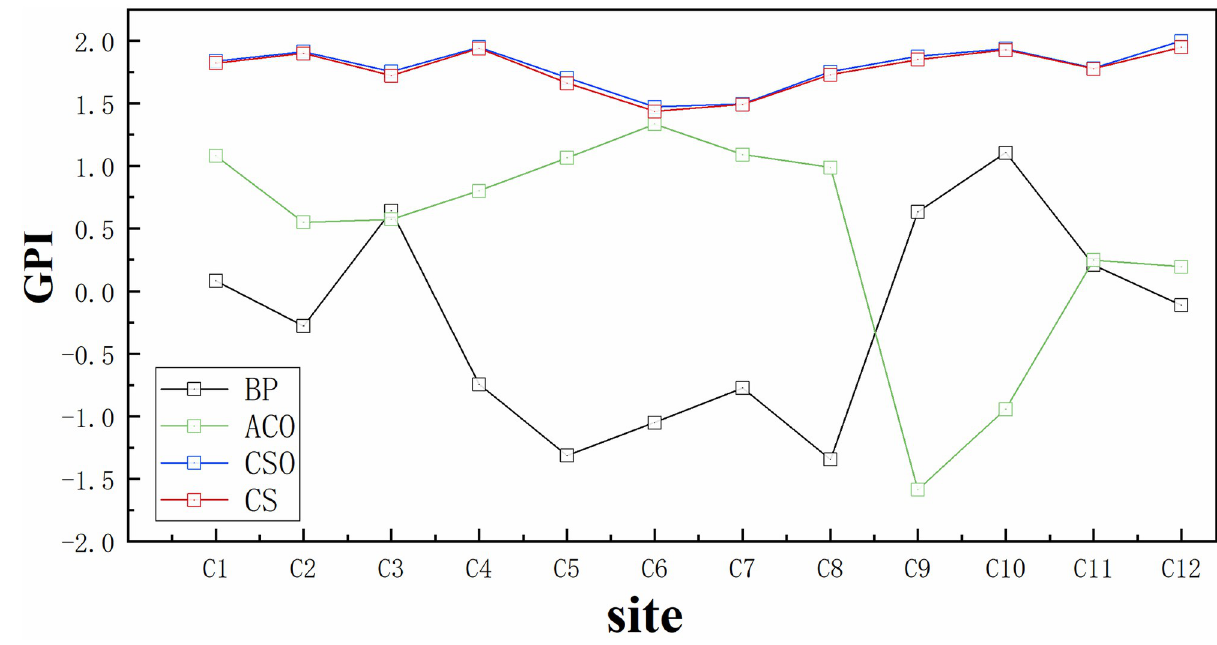
Fig 5. GPI performance of the four models at each